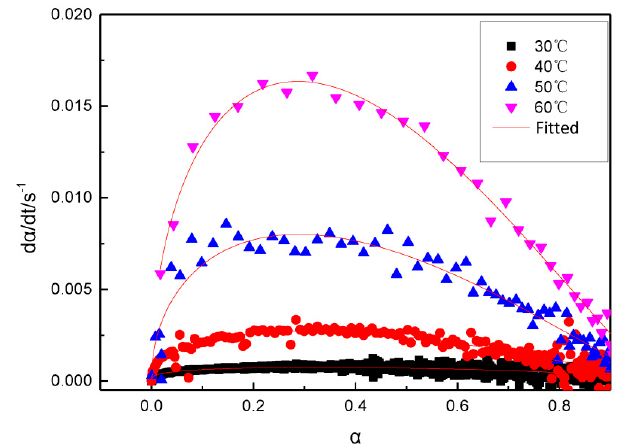
Figure 5. Comparison between the fitted data using the model and the experimental data.